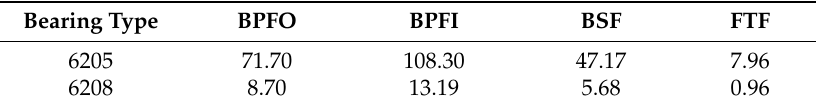
Figure 10. Low speed (LS) left bearing faults: ( a ) inner race fault; ( b ) ball fault. Table 1. Characteristic frequencies of bearings (Hz). BPFO: ball pass frequency outer race; BPFI: ball pass frequency inner race; BSF: ball spin frequency; FTF: fundamental train frequency.